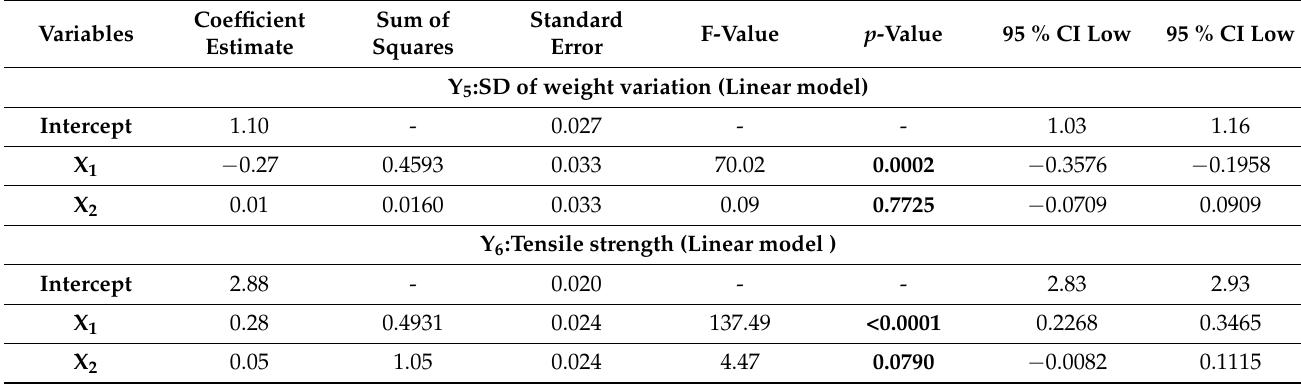
Table 8. Regression analysis of tablets measured responses.